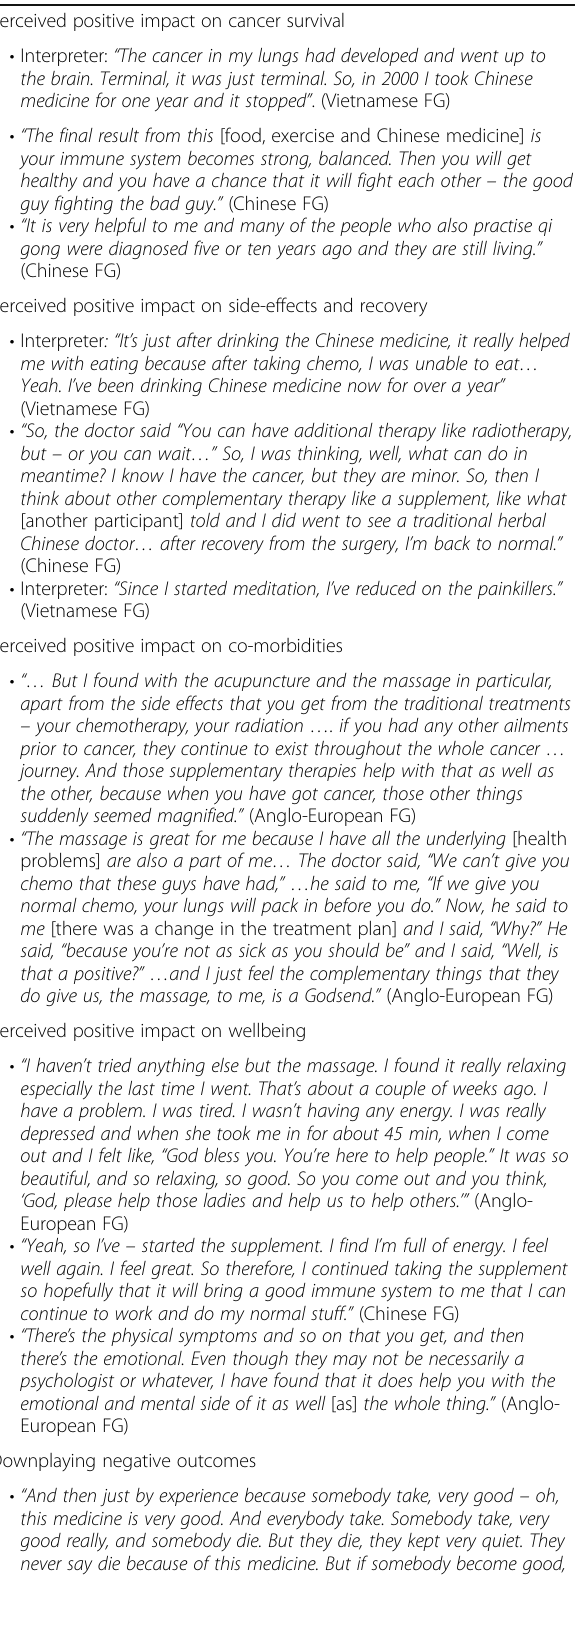
Table 4 THEME 1 - Positive perceptions &